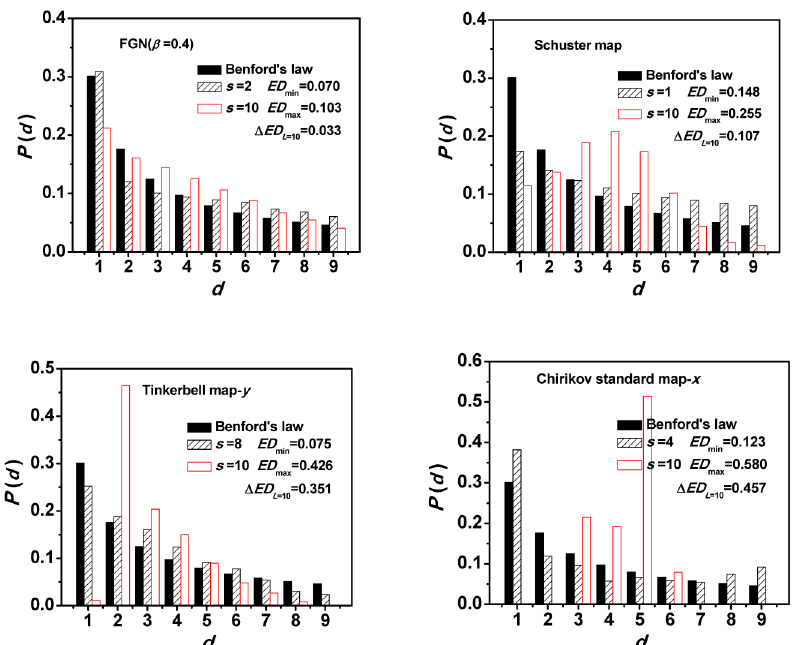
Fig 1. Fourtypical examples of the first digit distribution for time series at different scales. The stochastic process: FGN β = 0.4,the noninvertible chaotic maps: Linear congruential generator, the dissipative chaotic maps: Tinkerbell map- y and the conservative chaotic maps: Chirikov standard map- x .